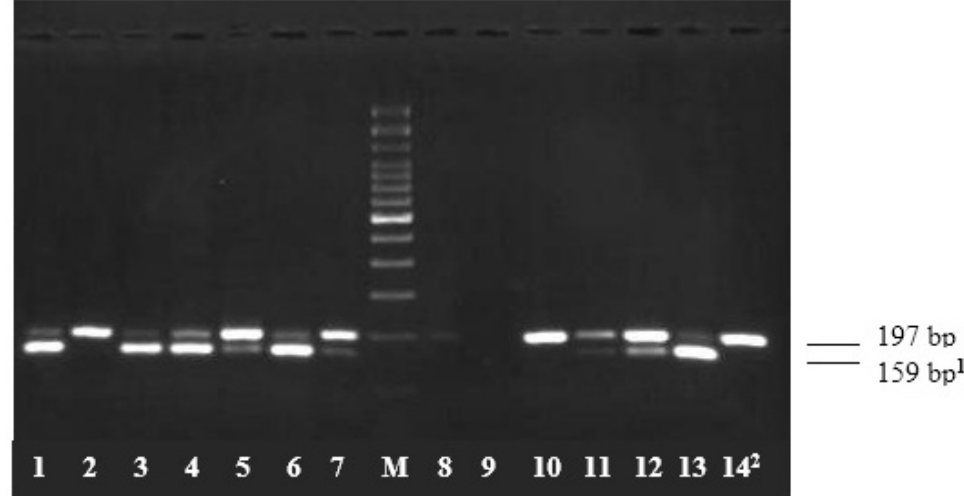
Figure 1. Random sample of agarose gel electrophoresis of restriction fragment length polymorphisms (RFLPs) products for C1q rs292001 single nucleotide polymorphism (SNP) stained with ethidium bromide. Samples numbered from 1 to 14 correspond to cases samples. M—DNA molecular weight marker (100 bp DNA ladder); bp— base pairs. 1 The 38 bp fragment is not shown in this figure. 2 Samples 1, 3, 4, 6, 13 correspond to G/G genotype of the C1q rs292001 SNP (159 bp and 38 bp bands); samples 5, 7, 11, 12 correspond to A/G genotype of the C1q rs292001 SNP (197, 159 and 38 bp bands); samples 2, 10, 14 represent the A/A genotype of the wild type (197 bp band); samples 8, 9 showed unclear zones in the present agarose gel electrophoresis and they have been